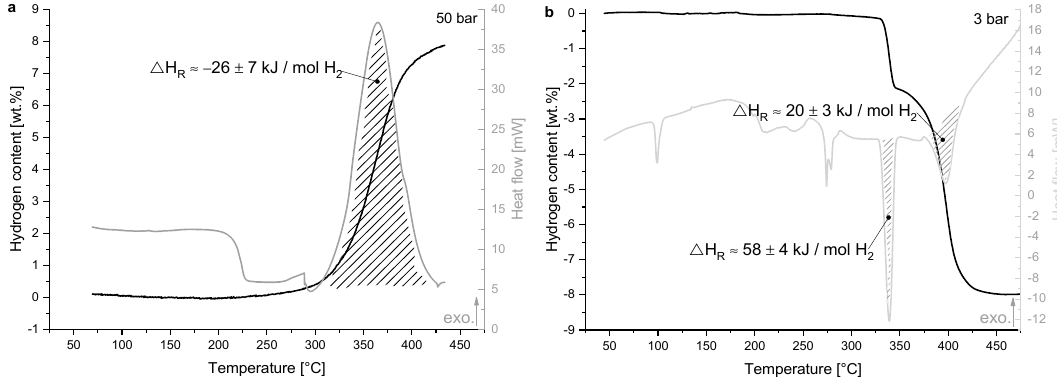
Figure 2. Hydrogen quantity and heat flow signal against sample temperature under 50 bar of H 2 in absorption conditions ( a ) and at 3 bar of H 2 , in desorption conditions ( b ).